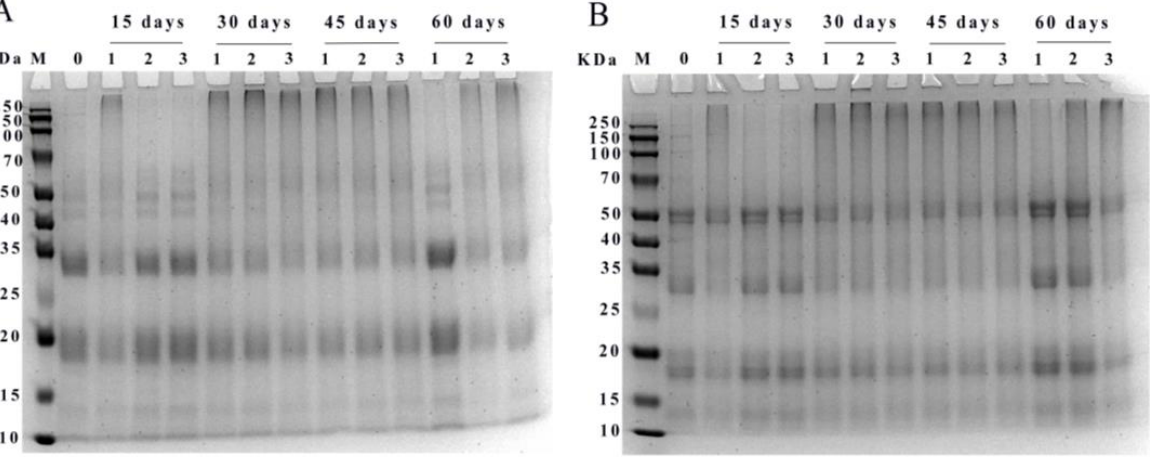
Figure 6. SDS-PAGE pattern of WPI under different storage conditions (( A ) reducing; ( B ) non-re- ducing; 0: storage for 0 days; 1: PE-sealed packaging; 2: PA/PE vacuum packaging; 3: PE/PET/AL vacuum packaging).